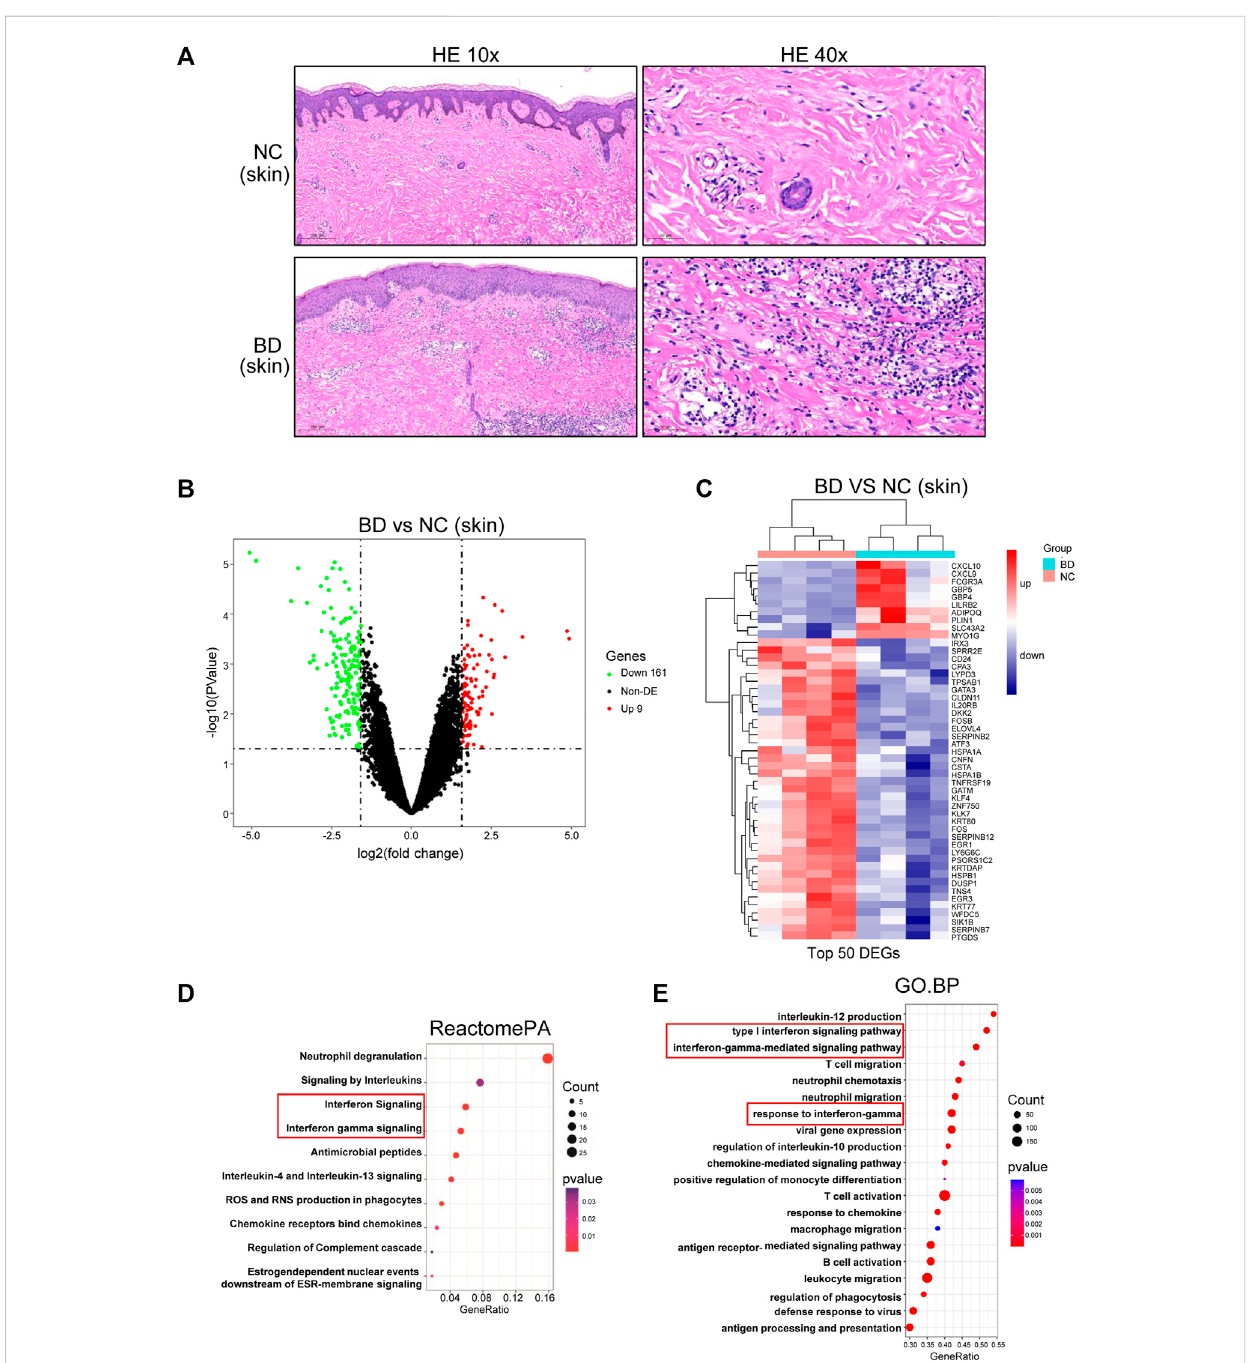
Differentially expressed genes(DEGs)inthe skin ofNC and BDpatients. (A) FFPE skin samples obtained fromBD patients and NCs werestained with hematoxylin and eosin (H&E). Representative images are displayed. Images in the upper panel demonstrate leukocytoclastic vasculitis in the super fi cial dermis and many lymphocytes and few neutrophils around the dermis and subcutaneous blood vessels. In contrast, representative images in the lower panel, which were from NCs, demonstrate that no in fl ammatory cells had in fi ltrated the skin. The scale bar of the left panel is 200 µm (magni fi cation, ×10), and that of the right panel is 50 µm (magni fi cation, ×40). (B) Volcano plot showing the DEGs in skin comparing the BD and NC samples (criteria: p < 0.05 and absolutefold change > 3,abs (foldchange) > 3).Red,signi fi cantupregulation; Green,signi fi cantdownregulation; black, not signi fi cant. (C) Heatmap showing the top DEGs in skin when comparing BD vs. NC samples (criteria: adjusted p < 0.05 and abs (fold change) > 4). (D) ReactomePA showing the pathways enriched with the DEGs. (E) GSEA analysis showing the DEG enriched pathways. The depth of the color represents the adjusted p -value. The area of the circles in the graph indicates the gene